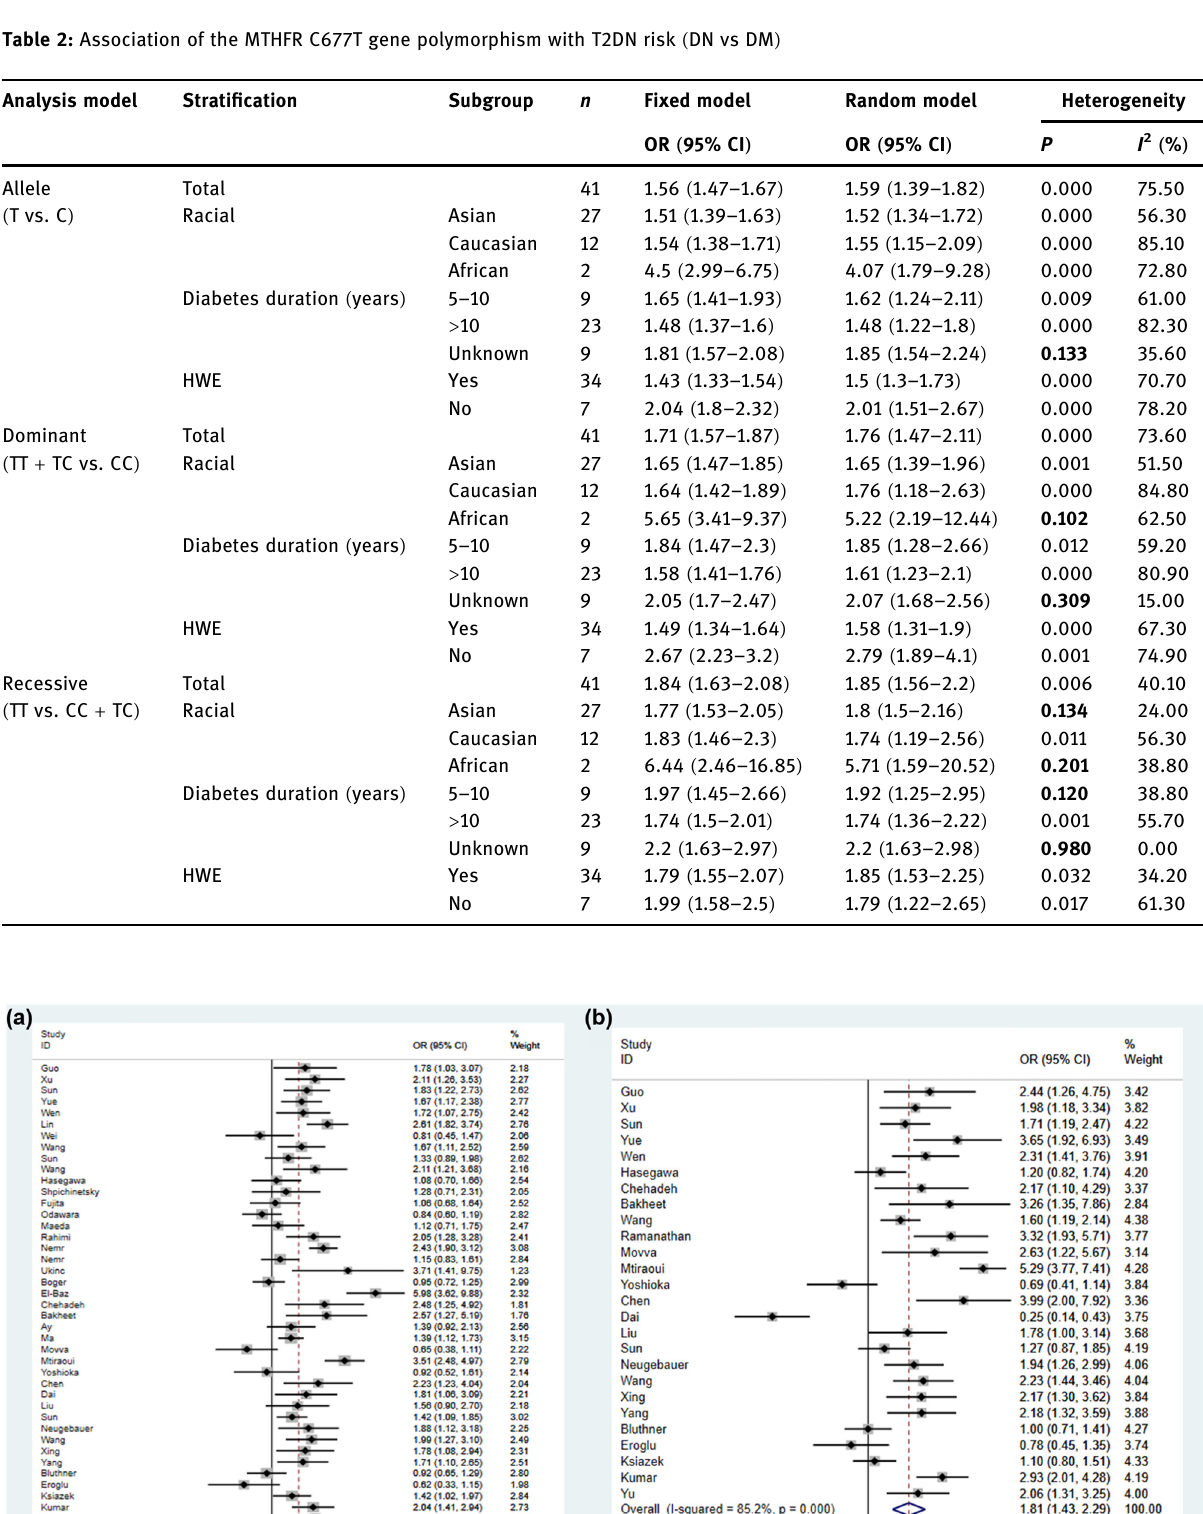
Table 2: Association of the MTHFR C677T gene polymorphism with T2DN risk ( DN vs DM )